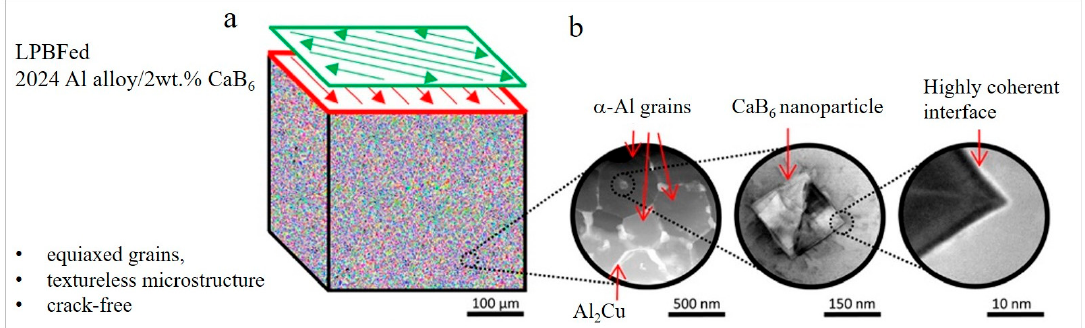
Figure 5. EBSD inverse pole figure grain orientation map of LPBFed 2024 alloy—2 wt.% CaB 6 ( a ), respective HAADF-STEM and ADF-STEM images of CaB 6 nanoparticles within α -Al grain ( b ) (HAADF-STEM stands for high-angle annular dark-field scanning transmission electron microscope, ADF for annular dark-field)(reproduced with permission from [28]).